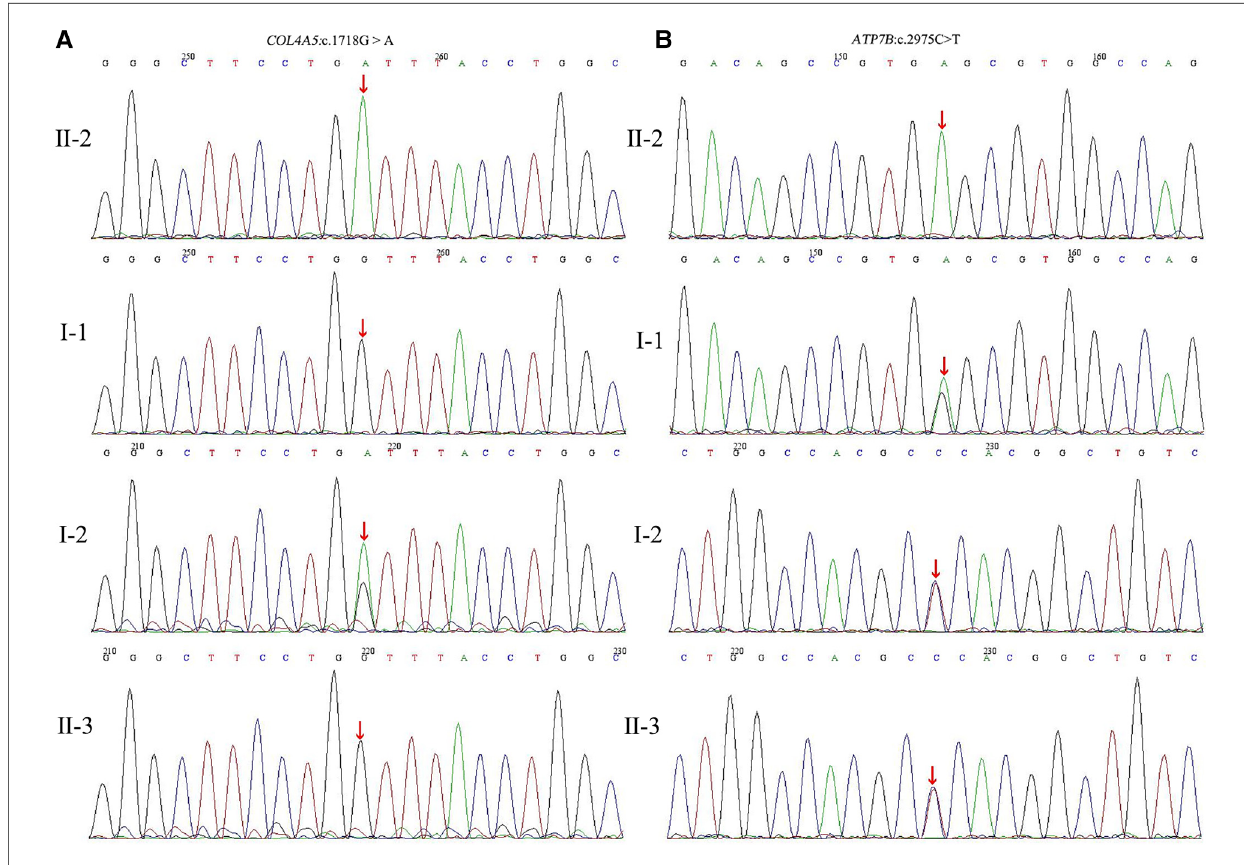
FIGURE 3 ( A ) Partial DNA sequences in the COL4A5 gene of the family. The proband (II-2) inherited hemizygous variation (c.1718G>A). The proband ’ s mother (I-2) carried the c.1718G>A heterozygous variant, but this gene was normal in the proband ’ s father (I-1) and younger brother (II-3); ( B ) Partial DNA sequences in the ATP7B gene of the family. The proband carried the homozygous mutation (c.2975C>T). The proband ’ s father, mother, and younger brother carried the c.2975C>T heterozygous